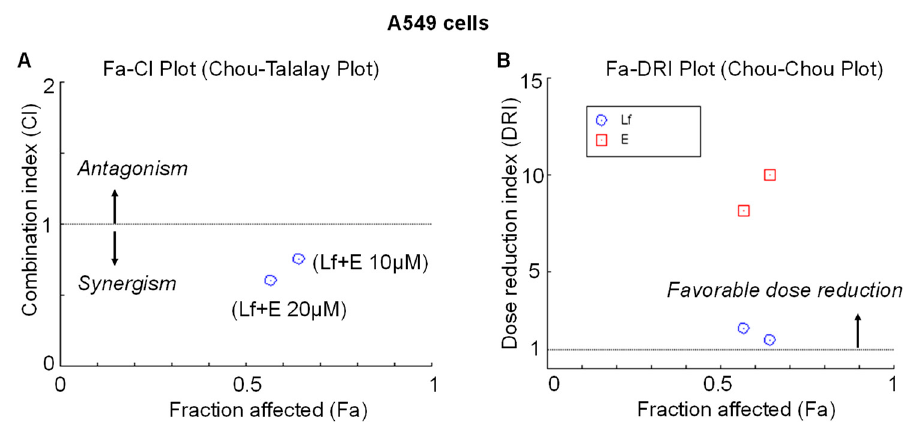
Figure 3. Analysis of the type of interaction between rhLf and etoposide in A549 cells by the Com- puSyn software. ( A ) Fa-CI plot (Chou-Talalay Plot) showing a synergistic effect of the combination rhLf (Lf) and etoposide (E) for each fraction affected. CI < 1 indicates synergism; CI = 1 indicates additivity; CI > 1 indicates antagonism; ( B ) Fa-DRI Plot (Chou-Chou Plot) represents an index of dose reduction for each fraction affected. DRI > 1 indicates favorable dose reduction; DRI < 1 indicates unfavorable dose reduction.